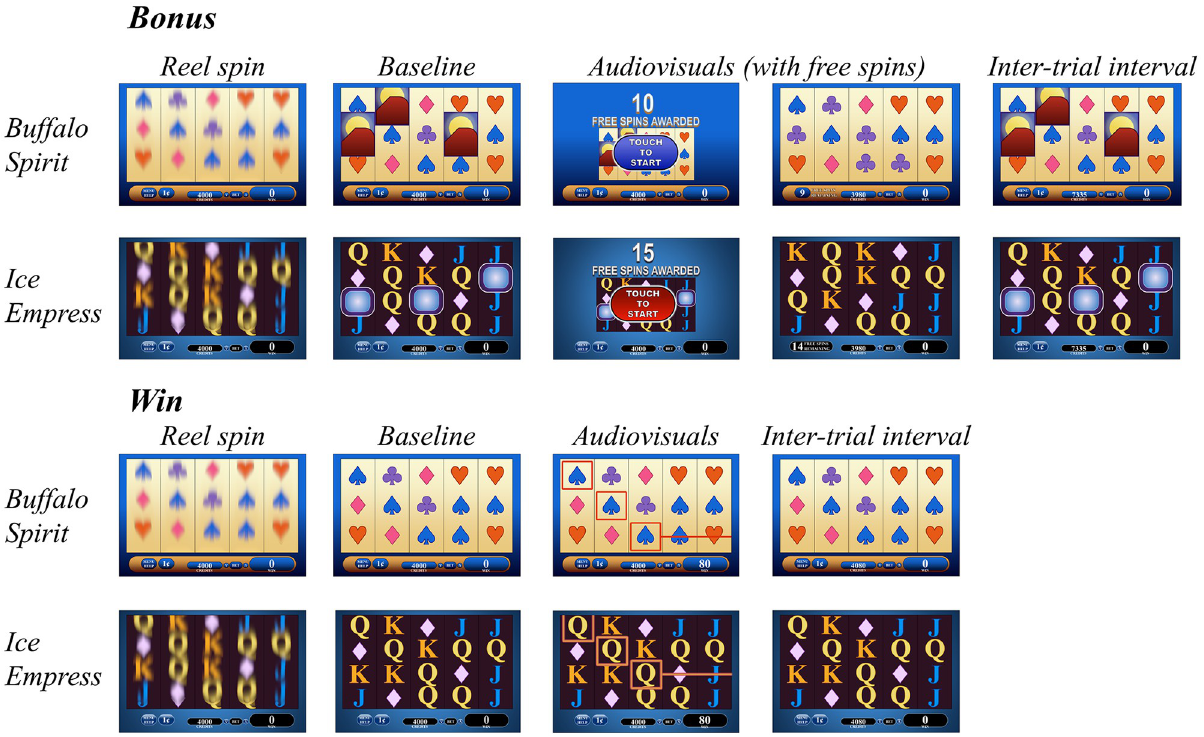
Fig 3. Illustrations depicting the sequence of on-screen events on free-spin bonus features and winning outcomes, for the two slot machine models used in the present study. These illustrations capture the approximate colour schemes and image dimensions of the key game elements. Researchers requiring actual screenshots should contact the corresponding author. Losses-disguised-as-wins follow similar in-game processes to the winning outcomes shown, and loss outcomes are similar to wins during the reel spin but do not contain any audiovisual feedback. Note the contrasting luminance properties for Buffalo Spirit (as a light screen background) and Ice Empress (with a darker screen background).